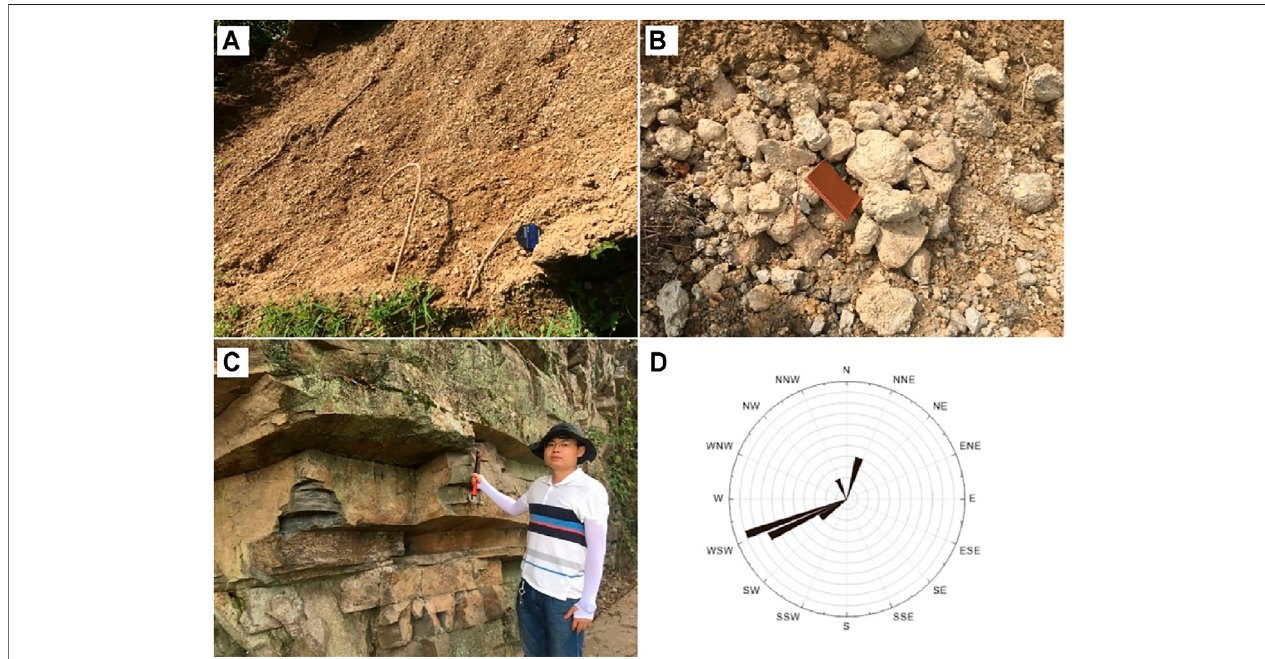
FIGURE 2 | (A) Eluvium, (B) gravel soil, (C) Hanjiadian Formation Shale (S1h), and (D) rose diagram of the joins.